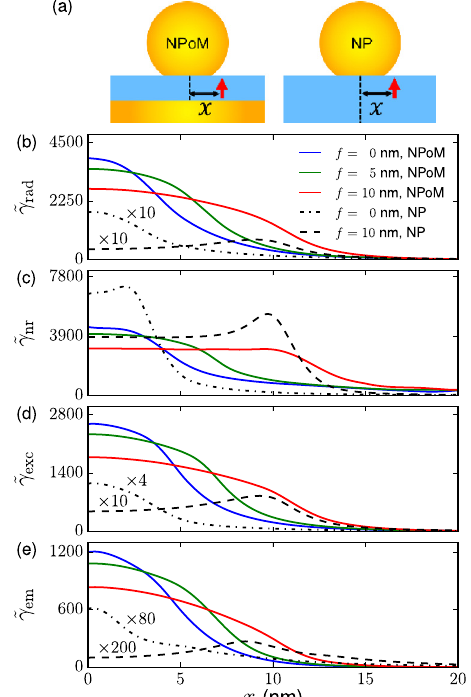
Fig. 2. (a) The radiative decay ~ g rad , (b) non-radiative decay ~ g nr , (c) excitation ~ g exc and (d) fl uorescence enhancements ~ g em for the NPoM nanocavities with facet diameter f =0, 5 and 10nm and the NPs on dielectric substrates with f = 0 and 10nm. For clarity, ~ g ~ g ~ g rad , exc and em for the NPs are multiplied by the indicated factors.